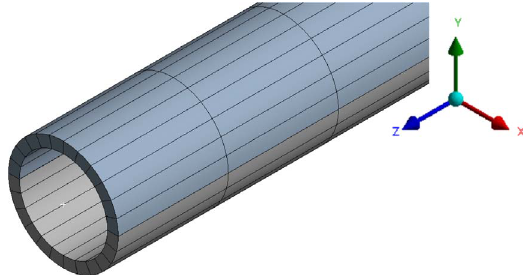
Figure 22. Discretization used for the asymmetric